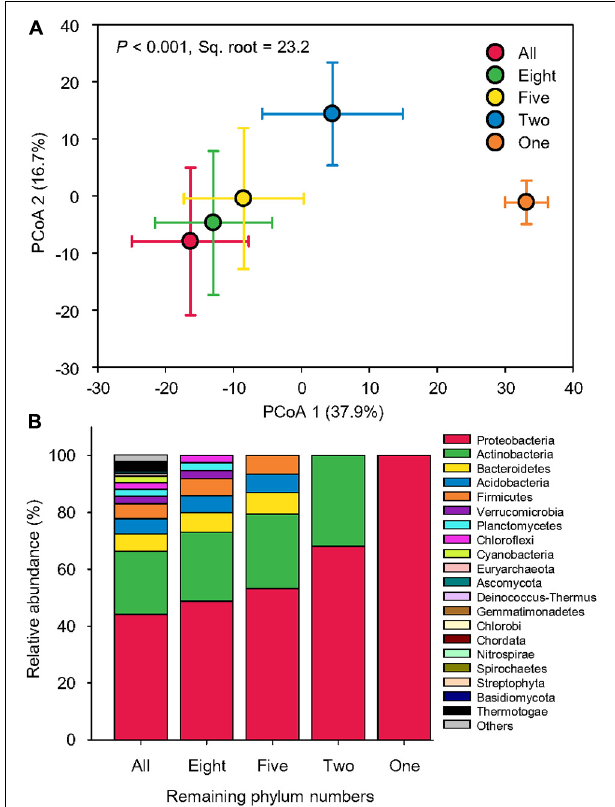
FIGURE 3 | Dramatic taxonomic variation. (A) Principal coordinate analysis (PCoA) showing the beta-diversity of taxonomic compositions at the genus level affected by sequential species loss. The error bars represent the standard deviation of data ranges. Variation explained by two principal coordinate dimensions is given in parentheses by percentage. p values and Sq. root of PERMANOVA are also given. (B) Relative abundance of dominant taxonomic compositions at the phylum level (mean > 0.2%) affected by sequential species